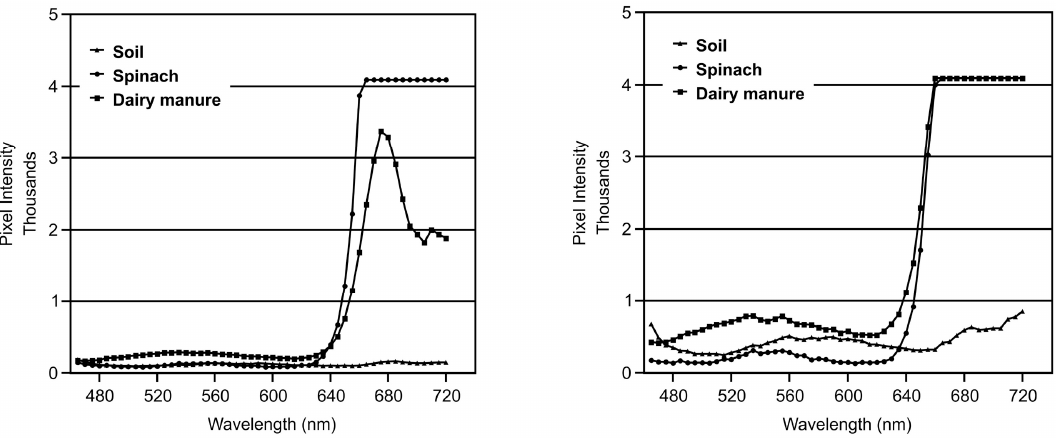
Figure 4. Spectra at gain 20 ( left ) and gain 32 ( right ) of soil, spinach, and dairy manure created using the images in Figure 3. Image was acquired at night with the drape raised 250 cm.